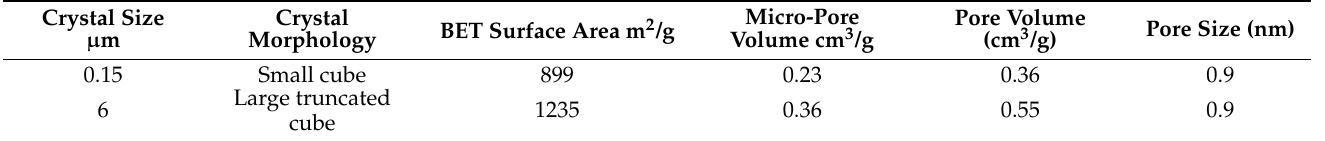
Table 2. Pore characteristics of the two sizes of UiO-66